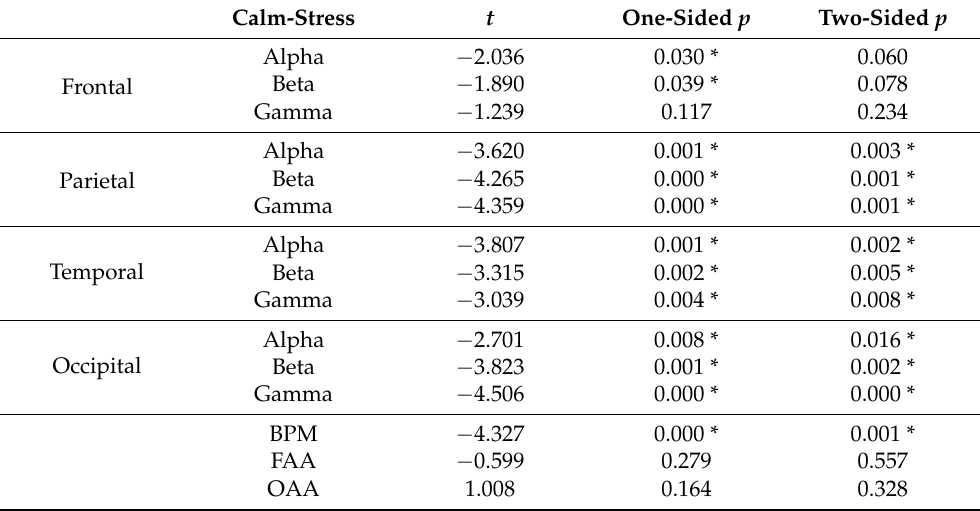
Table 1. Paired t -tests for each measure between the calm and stressed states. The * symbol indicates statistical significance with p value <